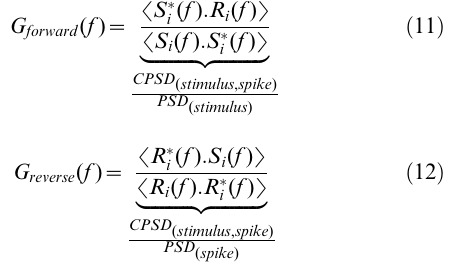
Figure S1 Input stimulus statistics affect the reliability of action potentials generated by the spiking neuron model. A. An example of a low mean, high standard deviation current stimulus (upper trace) and the action potentials evoked in the spiking neuron model with stochastic voltage-gated Na + channels and stochastic voltage-gated K + channels (middle trace). A raster plot (lower graph) of the action potentials evoked by presenting the same current stimulus 60 times. B. An example of a high mean, low standard deviation current stimulus (upper trace) and the action potentials evoked in the spiking neuron model with stochastic voltage-gated Na + channels and stochastic voltage-gated K + channels (middle trace). A raster plot (lower graph) of the action potentials evoked by presenting the same current stimulus 60 times. Figure S2 The effect of voltage-gated Na + or K + channel noise on action potentials generated by the spiking neuron model. A. An example of a low mean, high standard deviation current stimulus (upper trace) and the action potentials evoked in the spiking neuron model with stochastic voltage-gated Na + channels and deterministic voltage-gated K + channels (middle trace). A raster plot (lower graph) of the action potentials evoked by presenting the same current stimulus 60 times. B. An example of the action potentials evoked in the spiking neuron model with deterministic voltage-gated Na + channels and stochastic voltage- gated K + channels (middle trace) in response the same current stimulus (upper trace) as in A. A raster plot (lower graph) of the action potentials evoked by presenting the same current stimulus 60 times. Figure S3 Linear decoding performance using action potentials, generator potentials and graded voltage responses. A. The blue trace represents the input stimulus current while the red trace represents linear reconstruction based entirely on the spiking response. The current input had a mean and standard deviation set at 0 m A/cm 2 and 5 m A/cm 2 respec- tively. B. The blue trace represents the input stimulus current and the red trace represents linear reconstruction based entirely on the pseudo-analog response. C. The blue trace represents the input stimulus current while the red trace represents linear reconstruc- tion based entirely on the graded response. D. Normalized mean squared error (nRMSE) between the original and the reconstruct- ed input. The mean and standard deviation of the inputs were sampled from N(0, 2), N(0, 5), N(0, 10), N(5, 5), N(10, 5) and N(10, 10). E. Coherence based mutual information for the inputs in D. Figure S4 The effect of extrinsic noise on action potentials generated by the spiking neuron model. A. Total entropy, B. noise entropy, and C. mutual information of the spike trains generated in response to white noise current stimuli